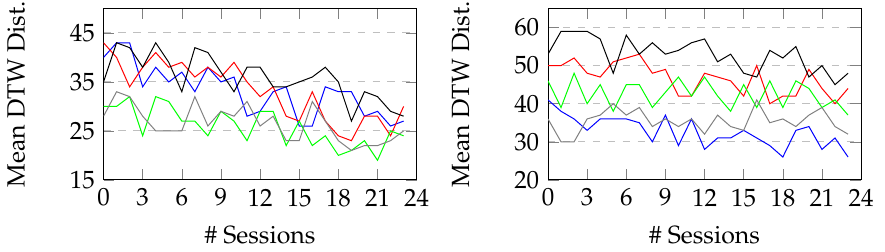
Figure 7. Evolution of the copy pose dynamic activity at ADACEA ( left ) and at the nursing home ( right